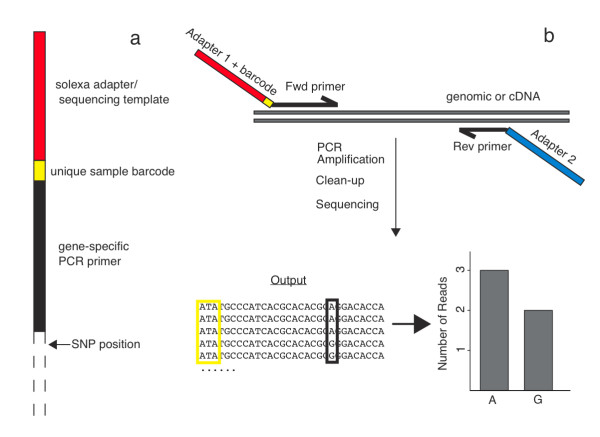
ASE using Solexa. Summary of sample preparation: (a) The forward primer is designed to anneal 1 bp upstream of the known SNP. The 5' tail contains a unique barcode and adapter sequences necessary for hybridization to the Solexa sequencing platform. (b) Model of target enrichment and allele-specific expression represented as sequencing coverage per allele.